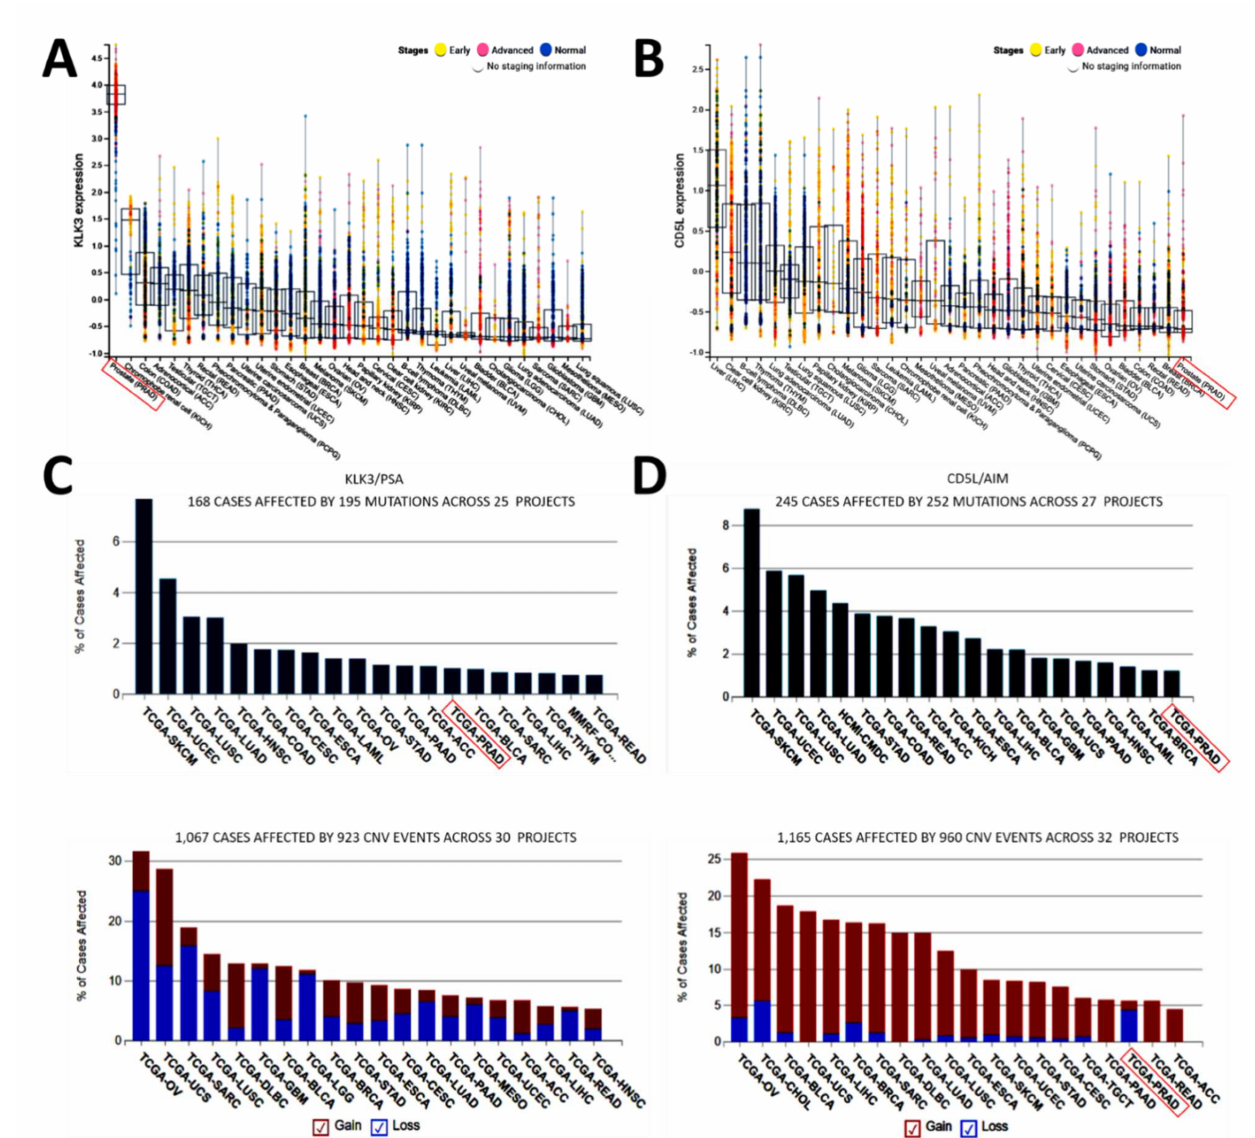
Figure 2. Aberrantly expressed PSA and significantly suppressed AIM expression characterize advanced stage prostate cancer, regardless of mutation status. Box and whisker and dot plots of the expression profiles of ( A ) PSA/KLK3 and ( B ) AIM/CD5L in normal tissue, early stage, or advanced stage disease across 32 cancer types from the ICR-curated dataset. Graphical representation of cases affected by ( C ) psa/klk3 and ( D ) aim/cd5l mutation ( upper ) or CNV ( lower ) in ICR-curated pan-cancer TCGA cohort data. ICR, Institute of Cancer Research; CNV, copy number variation; TCGA, the cancer genome atlas; PRAD, prostate adenocarcinoma; red box, PCa/PRAD